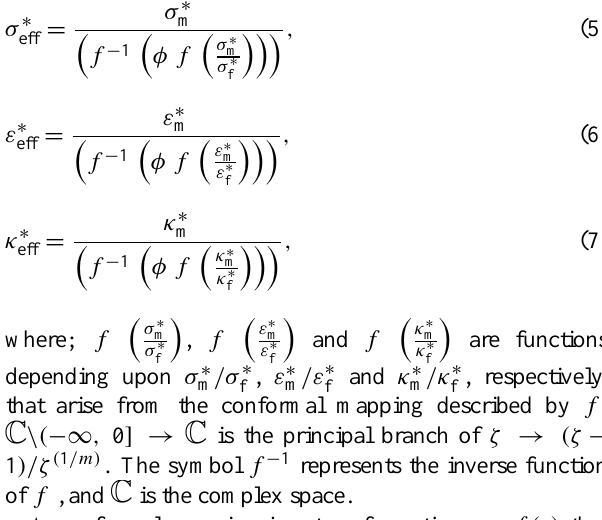
Fig. 1. Code required to run the conformal mapping Figure 1. Code required to run the conformal mapping solution.